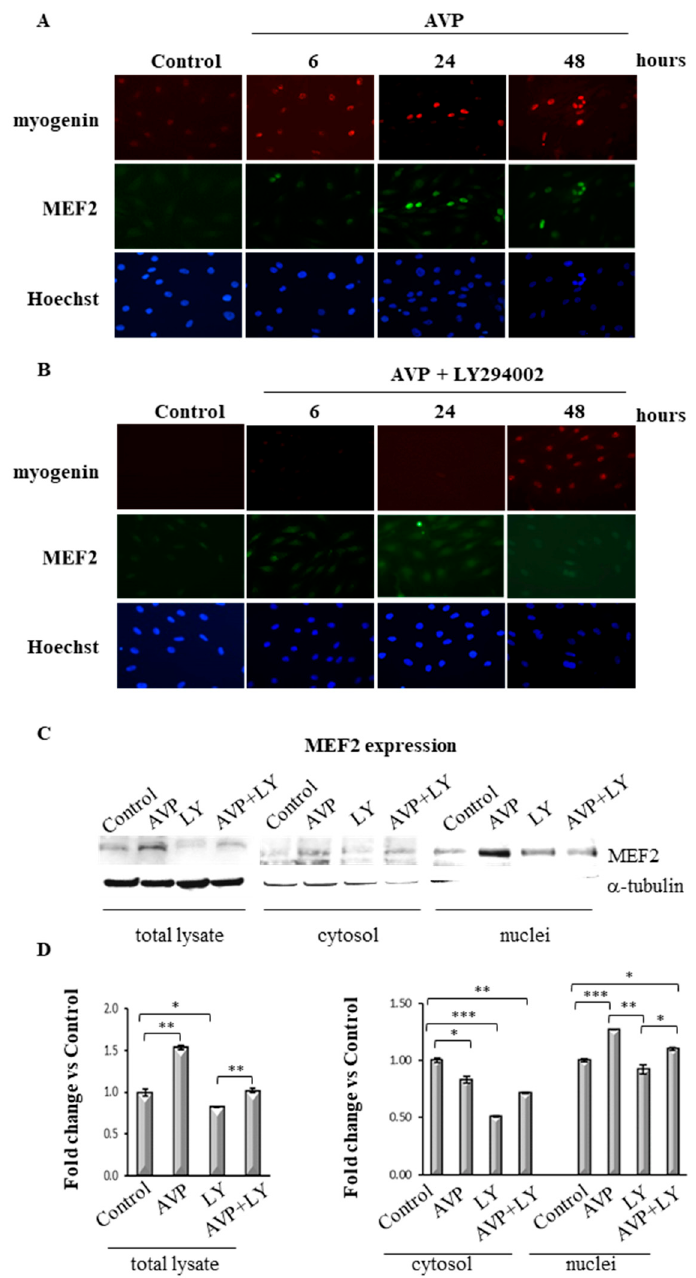
Figure 6. Myogenin and MEF2 expression / cellular localization are modulated by LY294002 in AVP-treated L6 cells. L6 cells were cultured in growth medium and after 24 h were shifted in serum-free medium and treated with 0.1 µ M AVP in the presence and in the absence of 20 µ M LY294002 for 48 h. ( A , B ) Immunofluorescence analysis was performed to evaluate the expression levels and cellular localization of myogenin and MEF2. (original magnification × 20). ( C ) Western blot analyses of total lysates and cytosolic and nuclear fractions were achieved to evaluate changes of cellular localization of MEF2 after LY294002 addition in AVP-treated and un-treated L6 cells. ( D ) Densitometric analyses were performed using an anti- α -tubulin antibody to verify the equal loading of the samples and the cytoplasmic contamination of the nuclear fractions. Nuclear and cytosolic fractions were normalized using Stain-free technology. Representative blots are shown. Statistical analysis was performed by Student’s t -test on data obtained from three independent experiments. * p < 0.05; ** p < 0.01; *** p < 0.001.